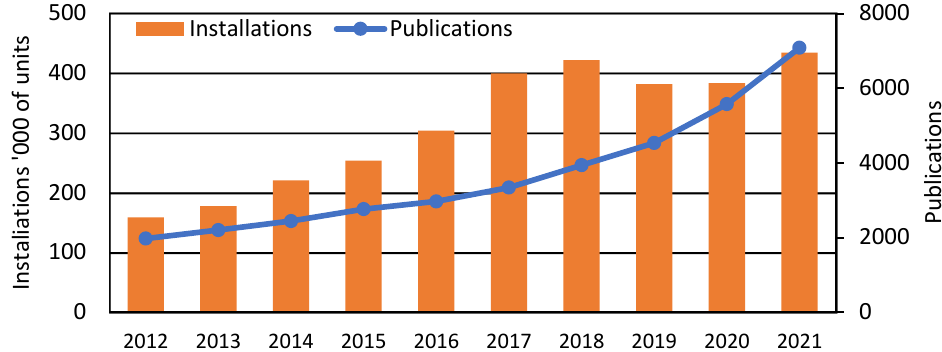
Figure 1. The annual ratio of publications to newly installed industrial robots.